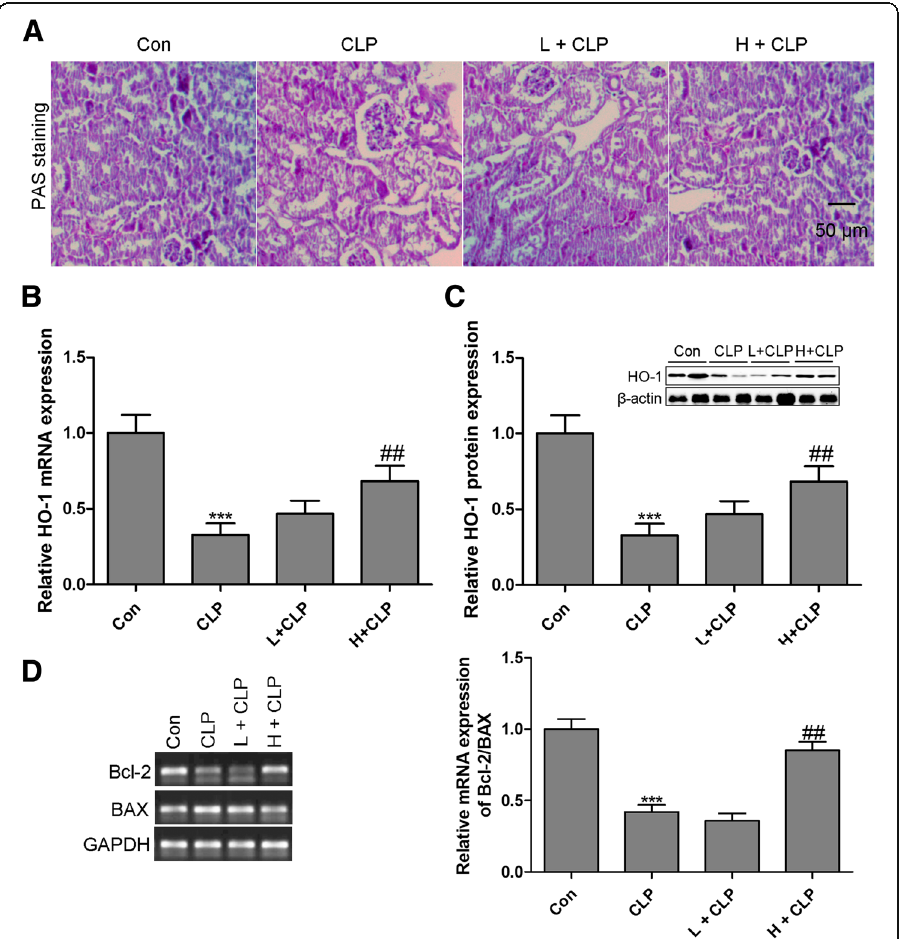
Fig. 4 Honokiol ameliorates AKI in septic mice by targeting HO-1. Renal pathology PAS staining (× 200) was performed in CLP-induced septic mice for 24 h ( a ). The mRNA ( b ) and protein ( c ) expression levels of HO-1 were measured by RT-qPCR and western blotting, respectively, in the kidney of septic mice. The mRNA expression levels of Bcl-2 and BAX were measured by RT-qPCR in the kidney of septic mice ( d ). Values are expressed as mean ± SEM, n = 10 in Con or H + CLP group and n = 8 in CLP or L + CLP group. *** P < 0.001, versus control group; # P < 0.05, ## P < 0.01, ### P < 0.001, versus CLP single treatment